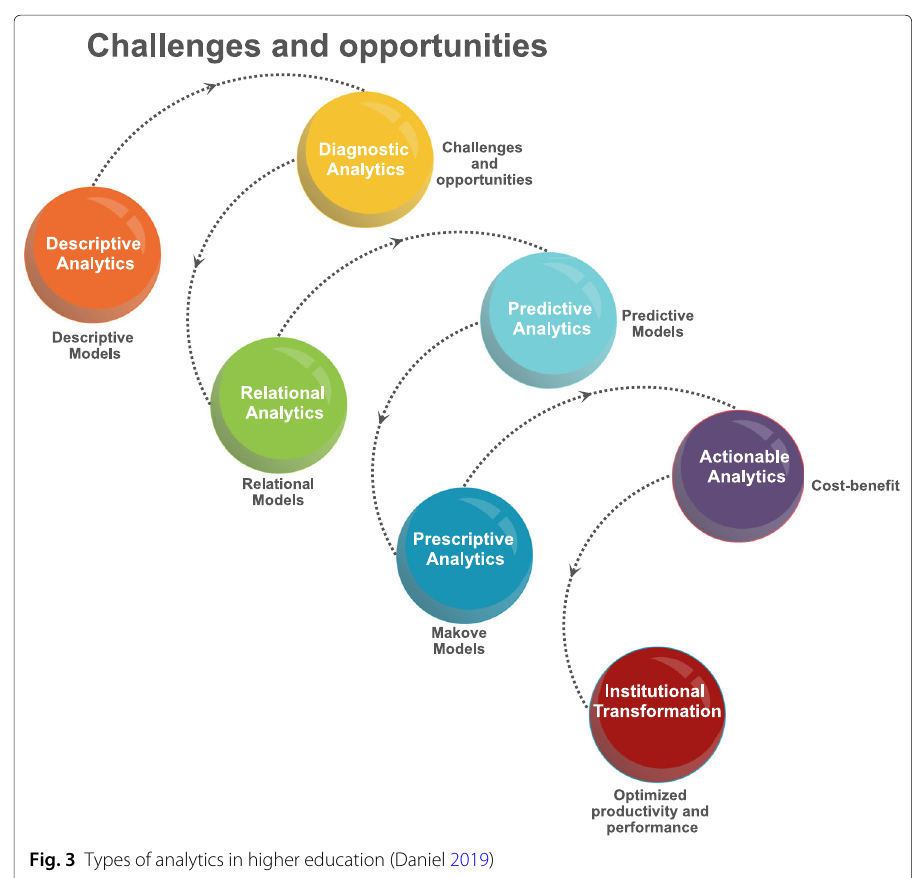
Fig. 3 Types of analytics in higher education (Daniel